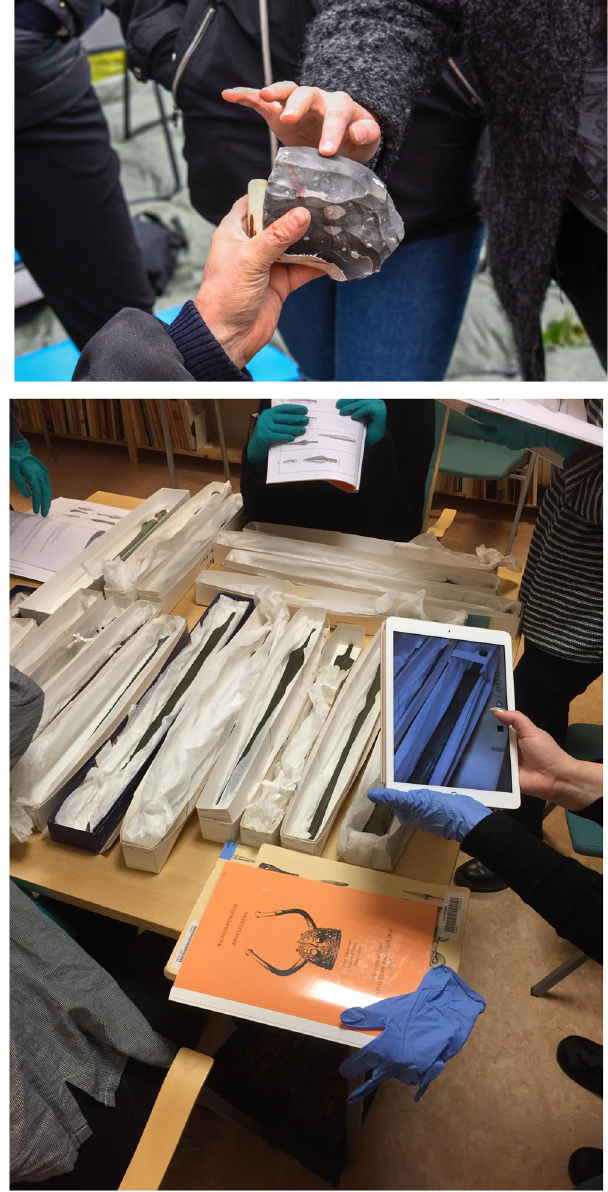
Figure 4: The physical engagement with materials and artifacts composes a vital part of the pedagogical framework on the courses in archaeology at Lund University. Photos by Åsa Berggren and Fredrik